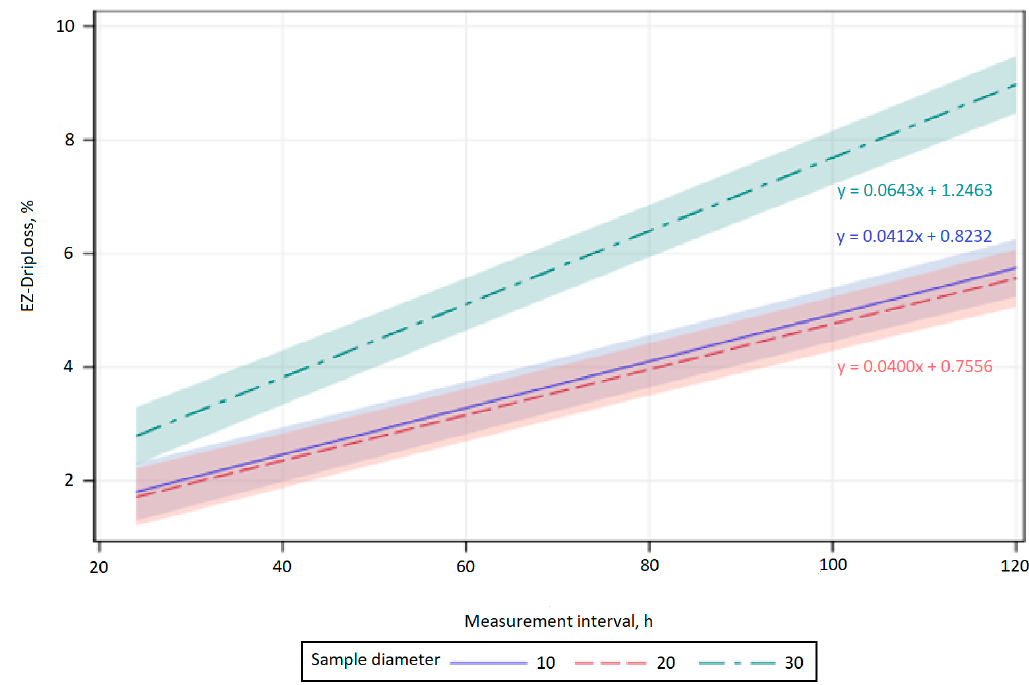
Figure 1. Predictions and confidence bands for a linear regression of measurement interval for EZ-DripLoss of chicken breast meat in relation to vertical fiber direction and core diameter (10, 20, and 30 mm).